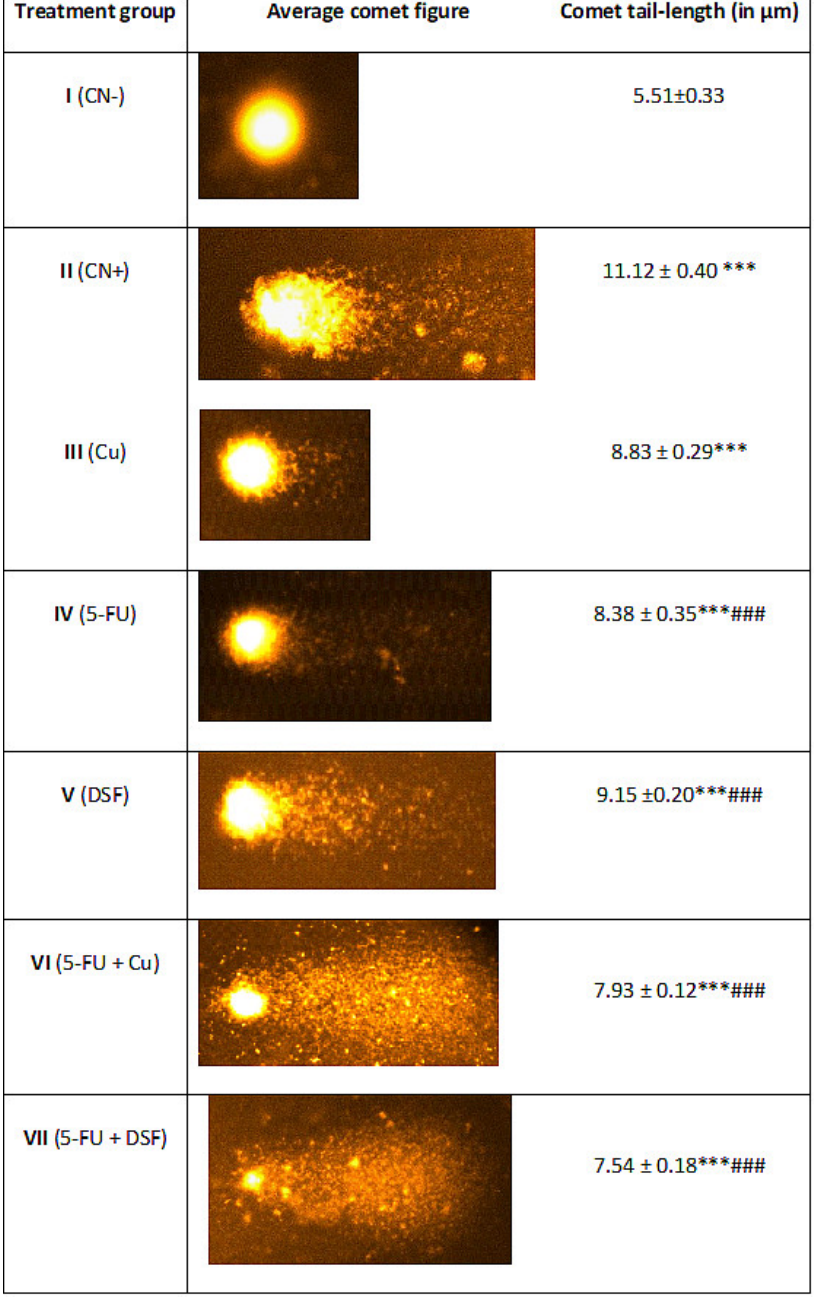
Figure 5. Average picture of the comet assay of liver cells of the treated groups. The comet tail lengths are in µm. The asterisk mark * indicates values significantly different from the control (group I), while # indicates values significantly different from the control positive (group II). All experiments were conducted in triplicate, and the data are presented as the mean ± SEM. p -values were calculated by Student’s t-test, *** or ### p < 0.001.